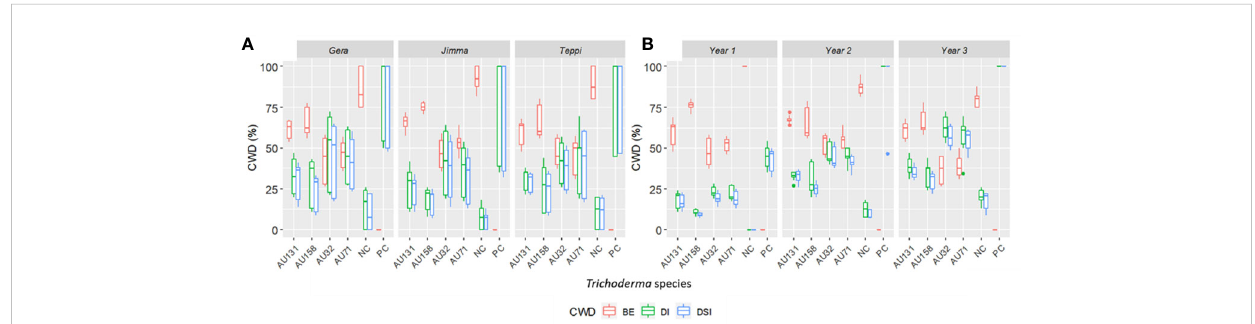
FIGURE 10 Boxplots showing cumulated incidence and severity of CWD, and biocontrol ef fi cacy (BE) of Trichoderma formulations. (A) Effect of Trichoderma treatments against F . xylarioides at three fi eld experimental sites and (B) Cumulated incidence and severity of CWD surveyed over three years. Trichoderma isolates: T. longibrachiatum AU32, T. asperellum AU71, T. asperellum AU131, T. longibrachiatum AU158. PC, Positive Control; NC, Negative Control; CWD, Coffee Wilt Disease; BE, Biocontrol Ef fi cacy; DI, Disease Incidence and DSI, Disease Severity Index. Year 1 = 2018/19, Year 2 = 2019/20 and Year 3 = 2020/21. The boundaries of the boxplots indicate the 25 th and 75 th percentiles, and the solid line within the boxes indicates the median value.